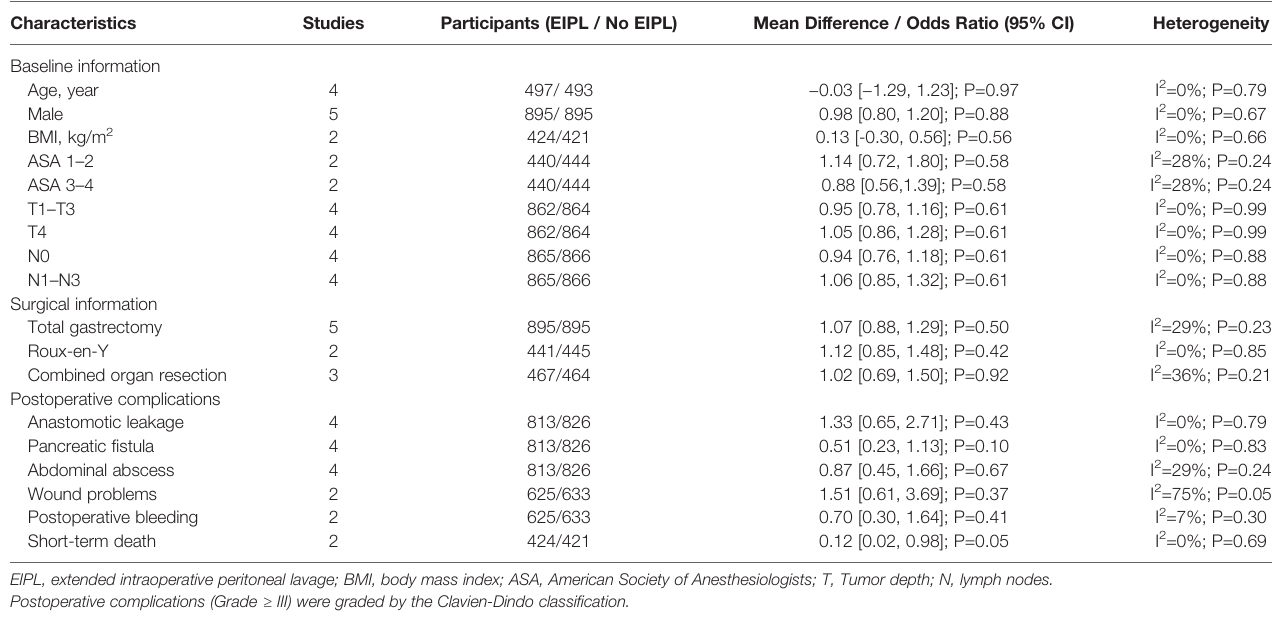
TABLE 2 | Summary of information between EIPL group and No EIPL group.